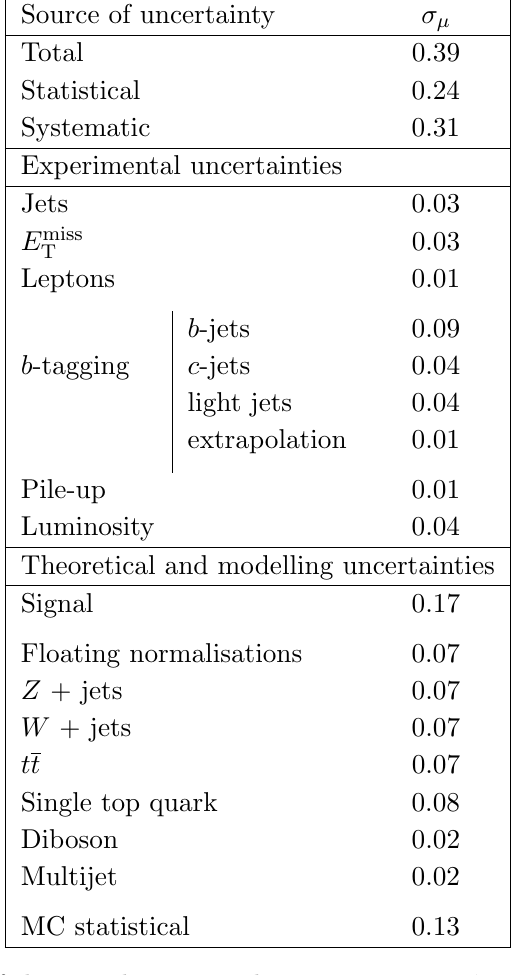
Table 11 . Breakdown of the contributions to the uncertainties in ^ (cid:22) . The sum in quadrature of the systematic uncertainties attached to the categories di(cid:11)ers from the total systematic uncertainty due to correlations. The b -tagging extrapolation uncertainty refers to the extrapolation of the b -jet calibration above p T = 300